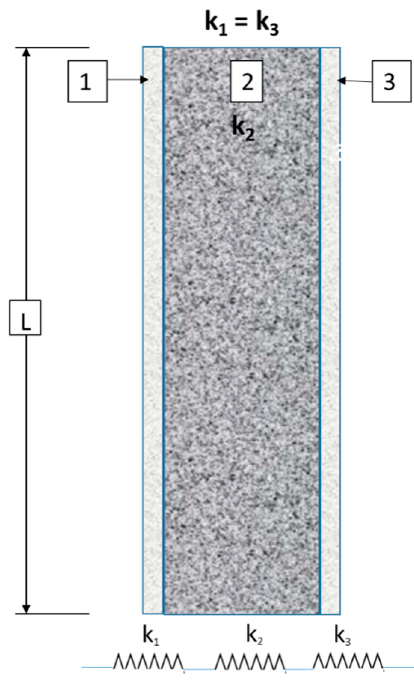
Figure 1. Wall-section of a typical building.